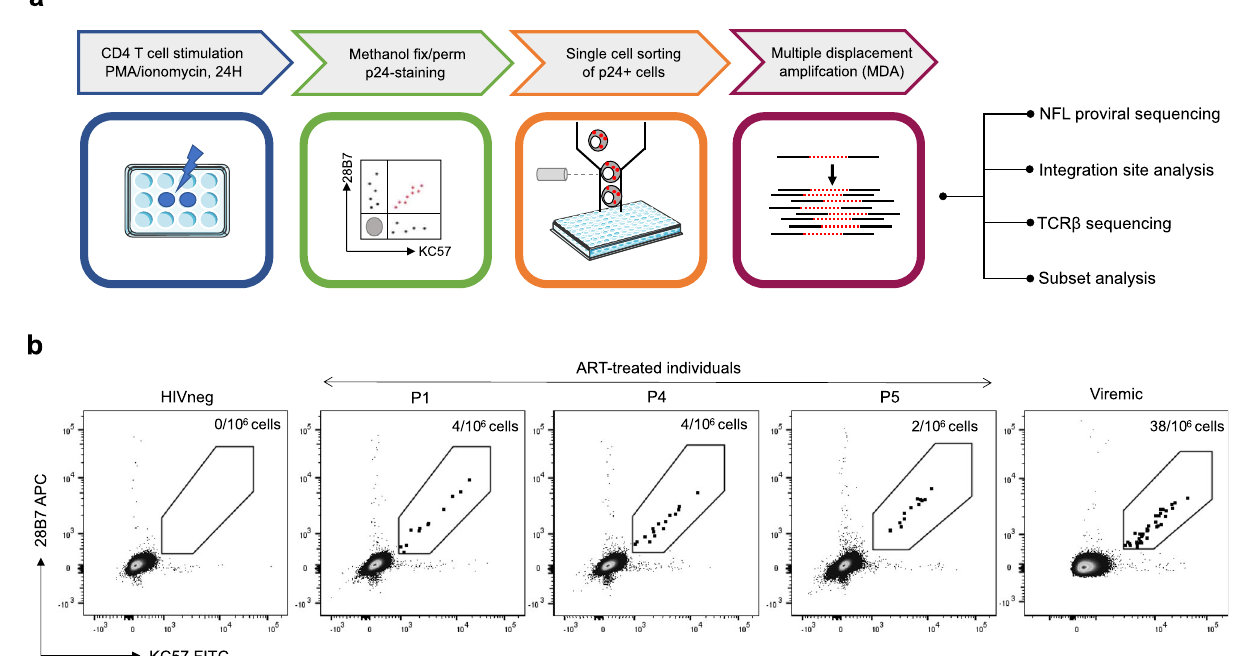
Fig. 1 STIP-Seq enables isolation and characterization of p24-producing cells after PMA/ionomycin stimulation. a Overview of the STIP-Seq assay. CD4 T cells are stimulated for 24 h with PMA (162 nM)/ionomycin (1 μ g/mL). Cells are fi xed and permeabilized with methanol, and p24-producing cells are identi fi ed using a combination of two antibodies (KC57 and 28B7) targeting the p24 protein. p24 + cells are single-cell sorted by fl ow cytometry. DNA from p24 + cells is ampli fi ed by multiple displacement ampli fi cation, before performing near full-length (NFL) proviral genome sequencing, integration site analysis, TCR sequencing, and post hoc determination of the CD4 T cell memory phenotype. The illustrations of the 96-well plates were obtained from SMART (Servier Medical Art; http://smart.servier.com/), licensed under a Creative Common Attribution 3.0 Unported license (https://creativecommons. org/licenses/by/3.0/). NFL near full-length. b Representative FACS dot plots showing the KC57-FITC/28B7-APC co-staining on CD4 T cells from one HIV non-infected control, one viremic, and three ART-treated